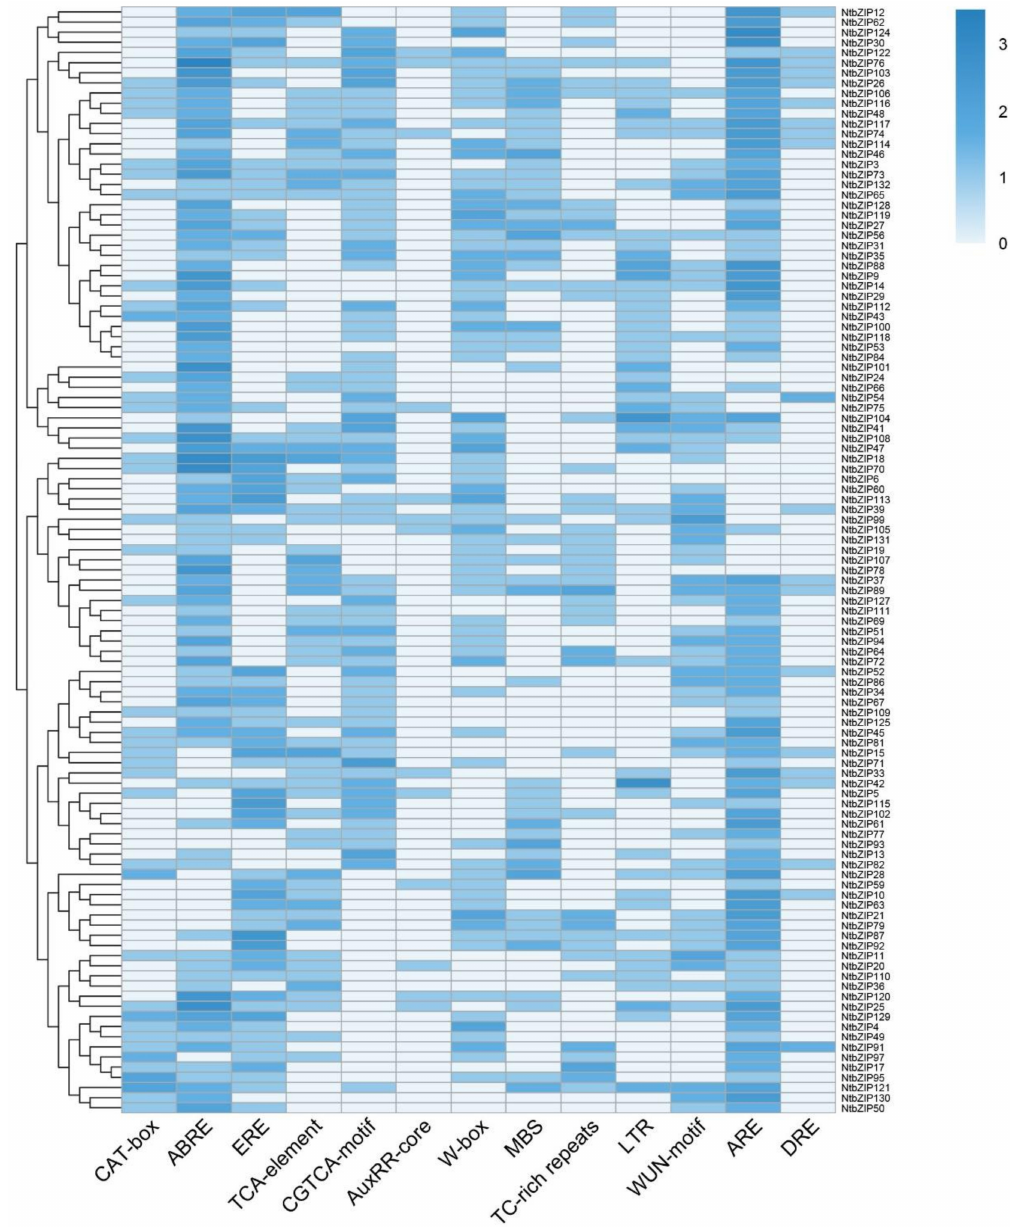
Figure 5. Statistics diagram of cis -elements in the promoter region of NtbZIP